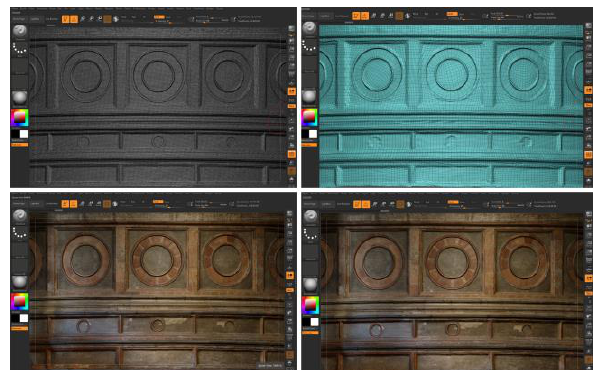
Figure 9. Workflow for the retopology of the mesh. On the left, the triangular mesh; on the right, the retopologized mesh. The apparent level of detail between the two meshes is the same.